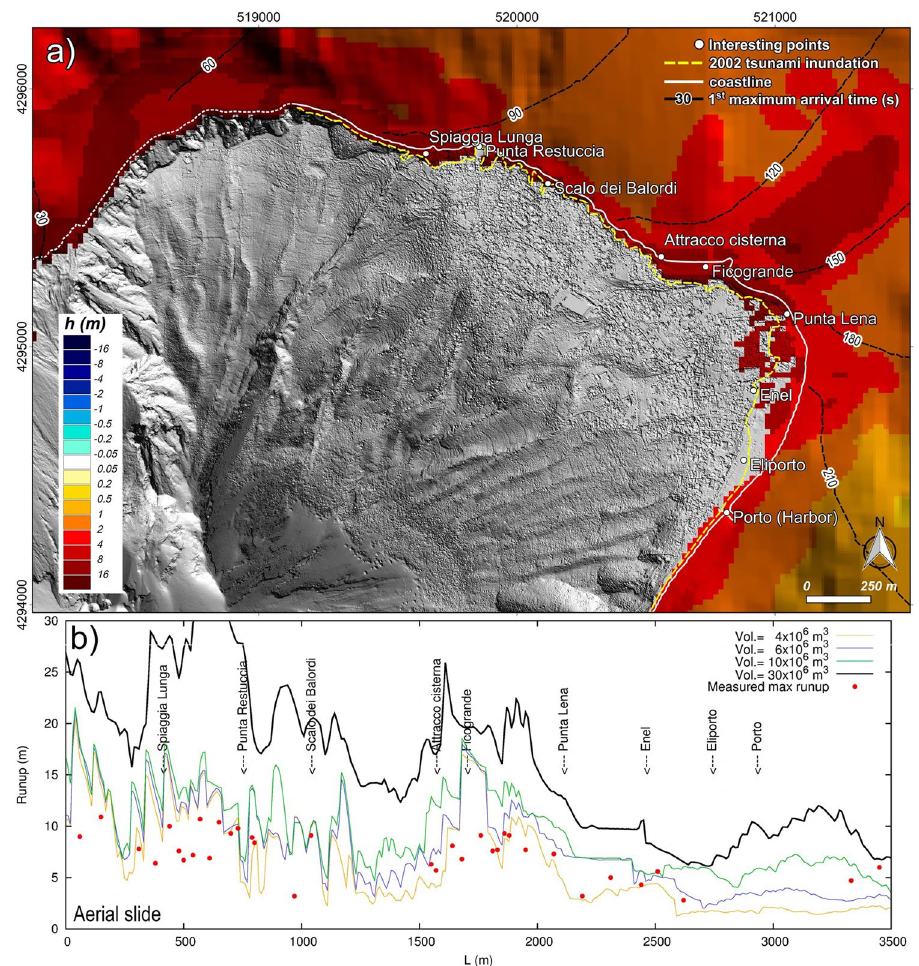
Figure 5. Observed and simulated tsunami effects comparison at Stromboli. ( a ) Stromboli map representing the maximum simulated inundation and wave height for a tsunami caused by an aerial slide along the SdF of 6 × 10 6 m 3 . Map was generated using Quantum GIS 2.8.1 software (https:// www. qgis. org). ( b ) Comparison between the 2002 runup observed by Tinti et al. 7 and runups simulated in case of subaerial